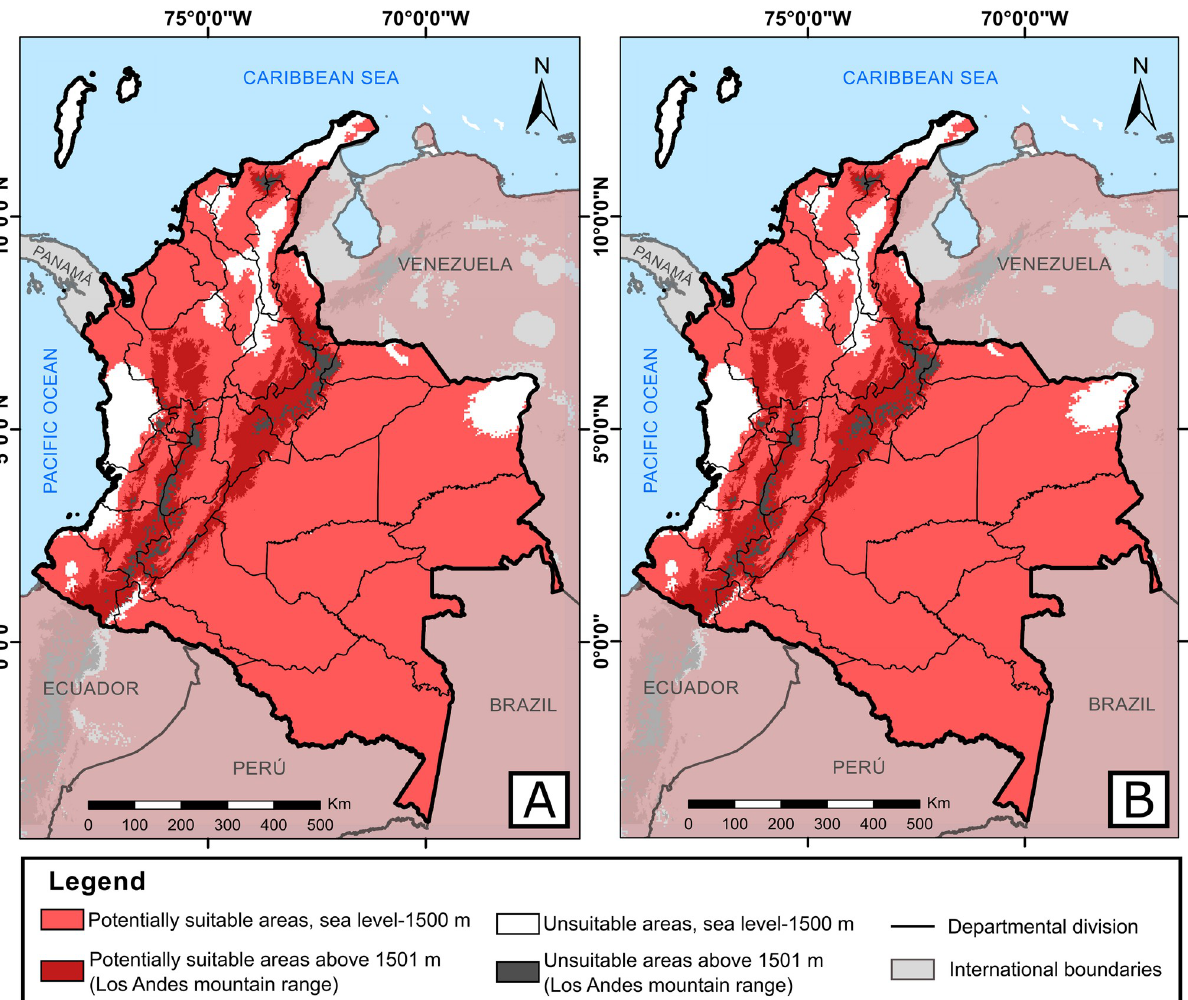
Fig 3. Potentially suitable areas to distribution of A . albopictus within a context of climate change for: A. 2050 and B. 2070, under the RCP 2.6 emission scenario. The light red corresponds to binary threshold. The maps were built using the free and open source QGIS software version 3.10.11 (https://www.qgis.org/en/site/about/index.html) and shapefiles were obtained from the free and open source DIVA-GIS site (https://www.diva-gis.org/ gdata).